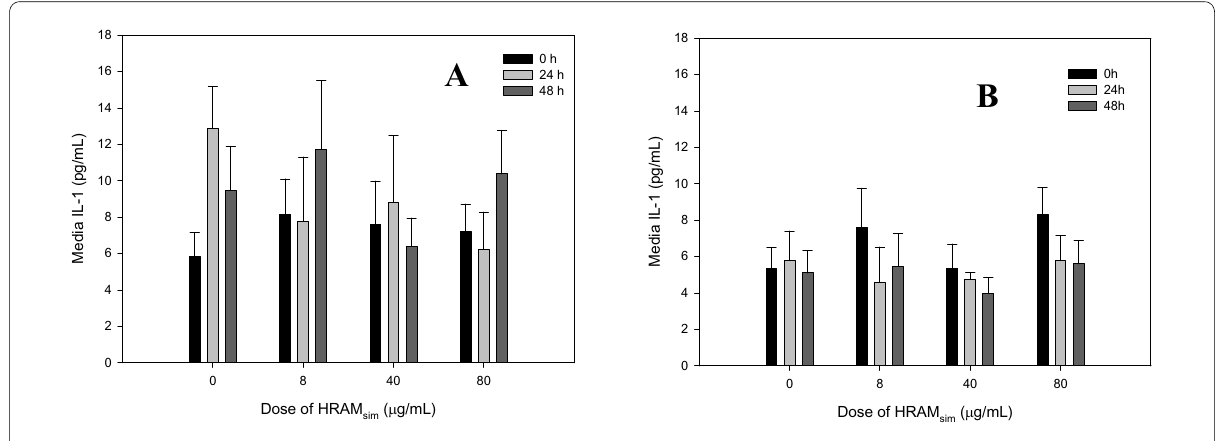
Figure 6 Interleukin-1β [IL-1] production by cartilage explants stimulated with LPS [3 or 0 μg/mL; Panels A and B, respectively] . Explants were conditioned with HRAM sim [0, 8, 40, or 80 μg/mL] for 96 h, and were stimulated with LPS for the final 48 h. Data shown are for the final 48 hours